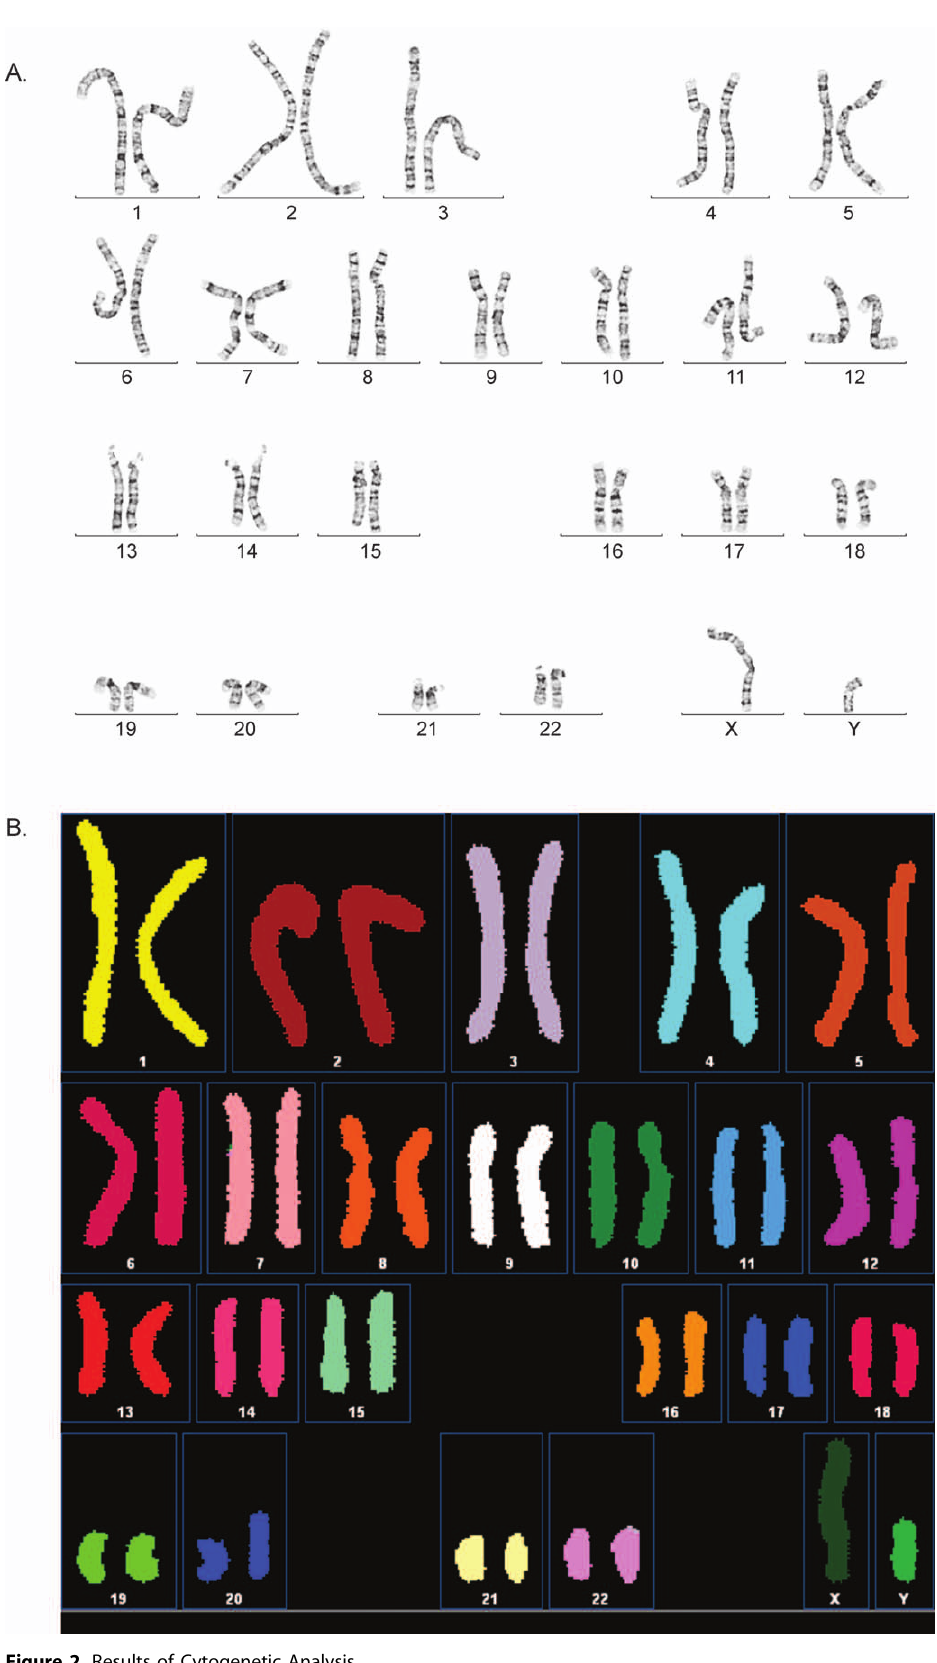
Figure 2. Results of Cytogenetic Analysis (A) HuRef donor G-banded karyotype. (B) Spectral karyotype analysis. doi:10.1371/journal.pbio.0050254.g002 PLoS Biology |